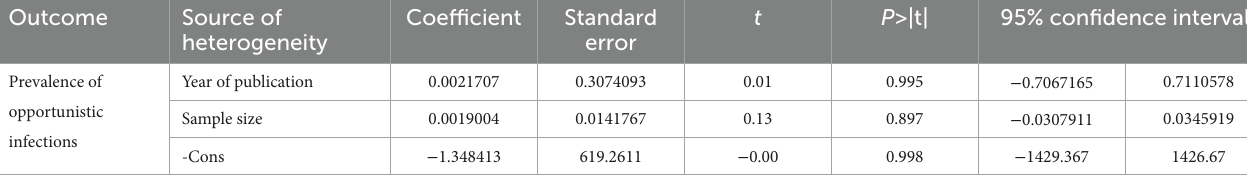
TABLE 2 Meta-regression analysis of factors affecting study heterogeneity. Outcome